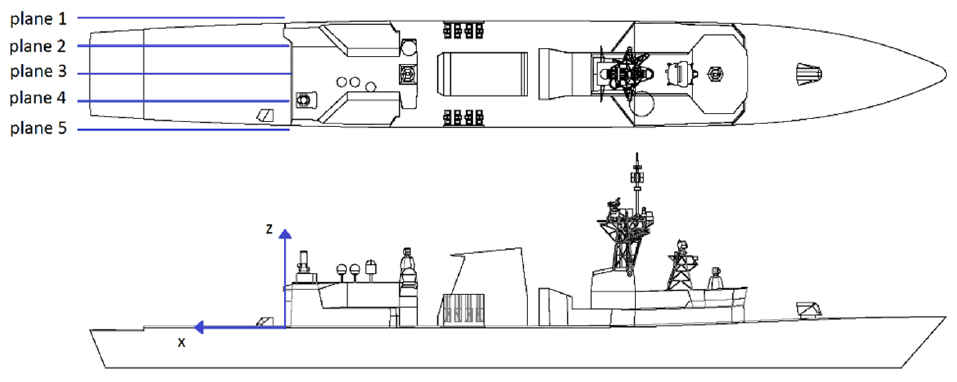
Figure 7. Layout of the PIV measurement planes located in the CPF ship airwake.